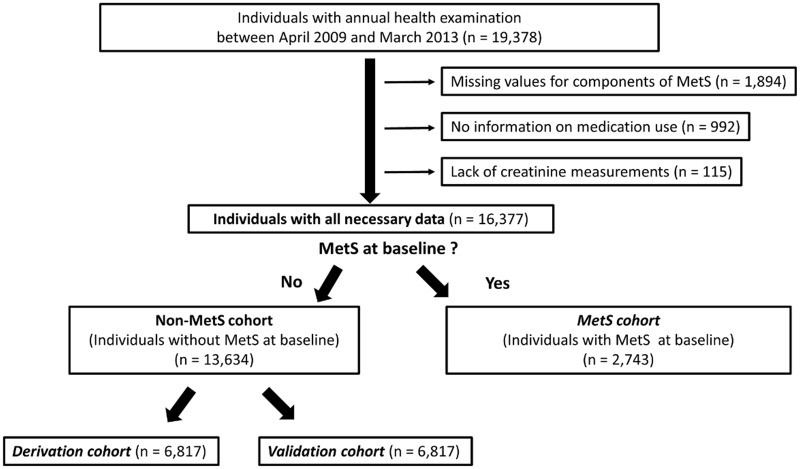
The study flow chart.MetS: metabolic syndrome.